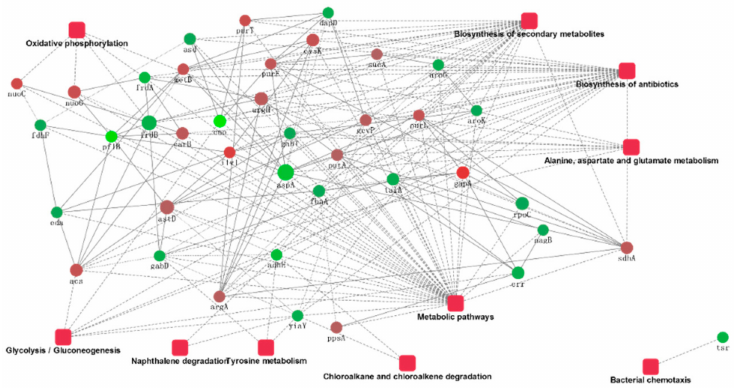
Figure 6. The protein–protein interaction